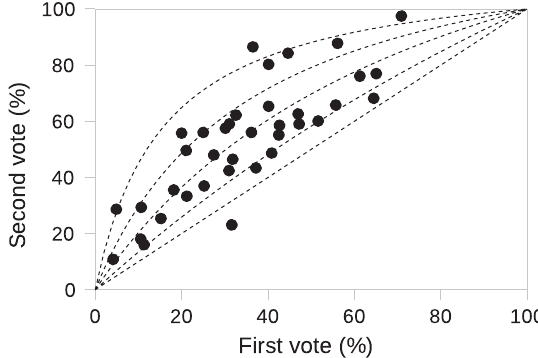
FIG. 4. Results of the peer discussion for the 37 ConcepTests. Each point is the proportion of correct students ’ answers to a given ConcepTest. Lines are isovalues of the Cohen ’ s d effect size (no effect, small, medium, large, and very large effect).